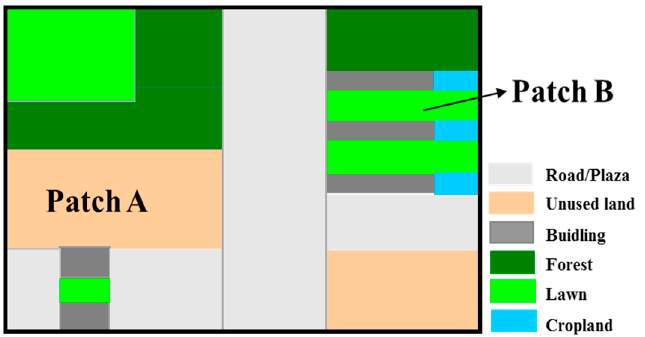
Figure 10. The determination of single catchment and mixed catchment. The black rectangle denotes the boundary of the D-B catchment, different color polygons in this figure denote different land uses, such as the grey color patches denote the road/plaza type.